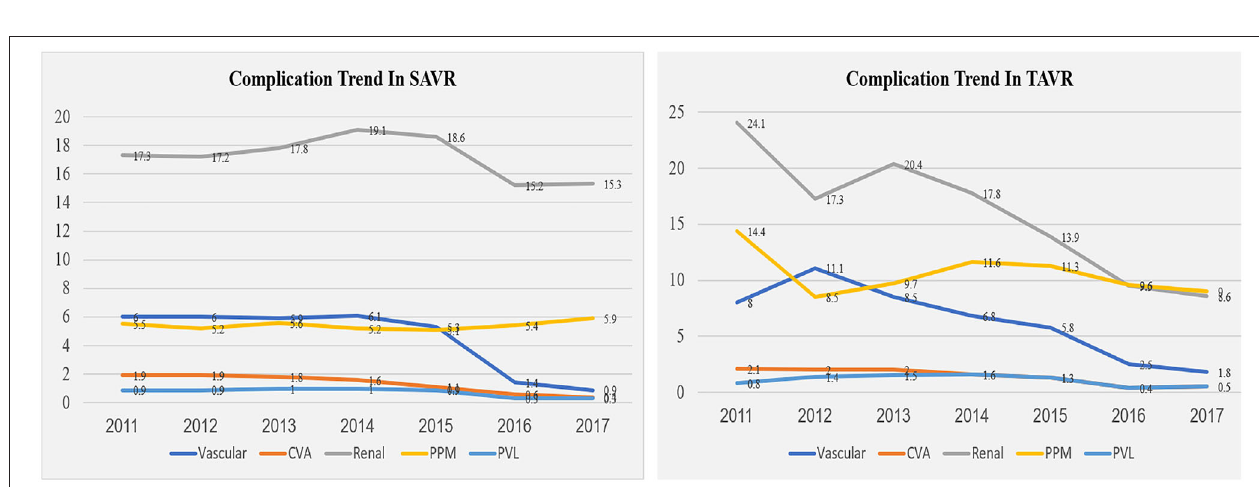
FIGURE 3 | Complication trend in the SAVR and TAVR groups during the years 2011–2017.